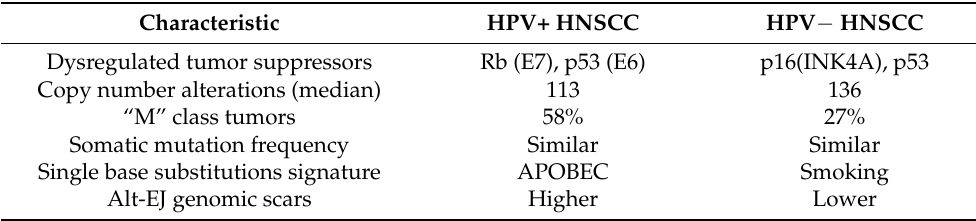
Table 1. Comparison of genomic characteristics and therapy response in HPV positive and negative